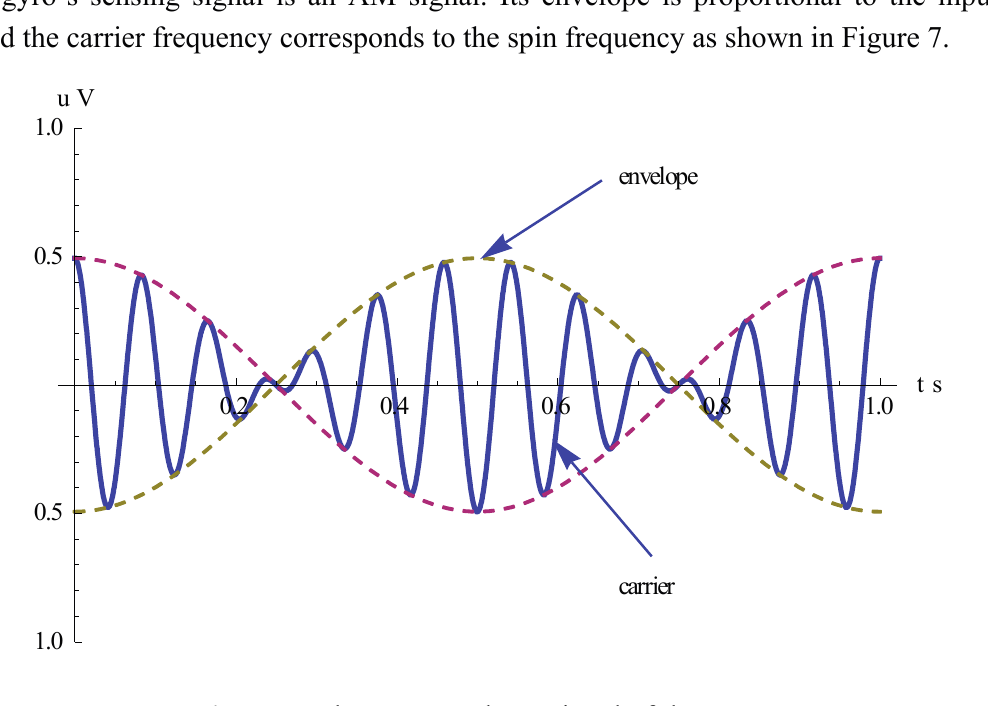
Figure 7. The output voltage signal of the